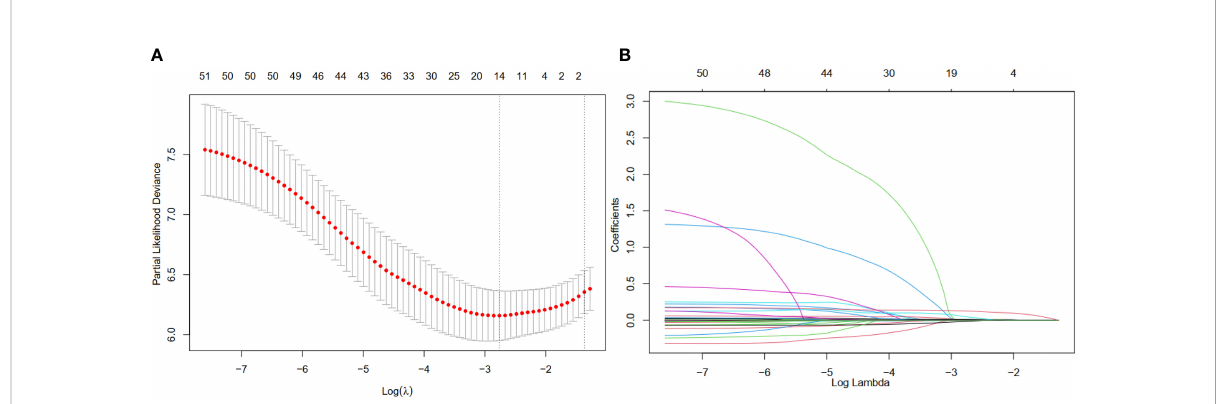
FIGURE 2 Feature selection using a least absolute shrinkage and selection operator (LASSO) regression model. (A) Tuning parameter ( l ) selection for the LASSO model involved fi vefold cross-validation using the minimal criteria. Dotted vertical lines were drawn at the optimal values; one standard error was added to each criterion to yield the 1-SE criteria. (B) The LASSO coef fi cients of the 49